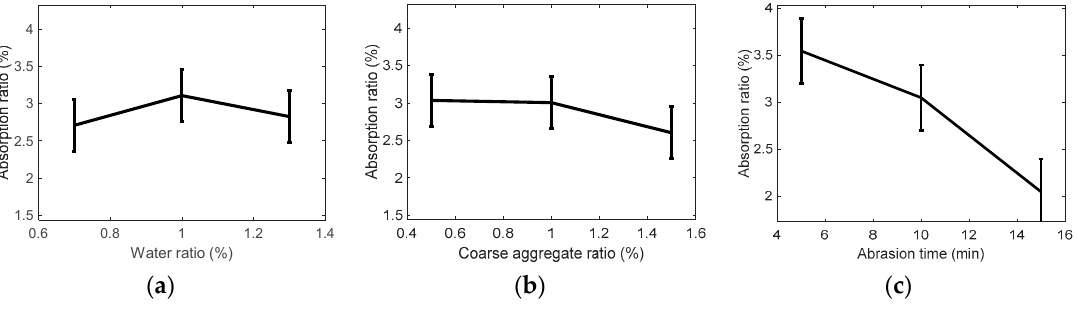
Figure 4. Assumed absorption ratio of recycled fine aggregate by variance analysis: ( a ) water ratio; ( b ) coarse aggregate ratio; and ( c ) abrasion crusher time.